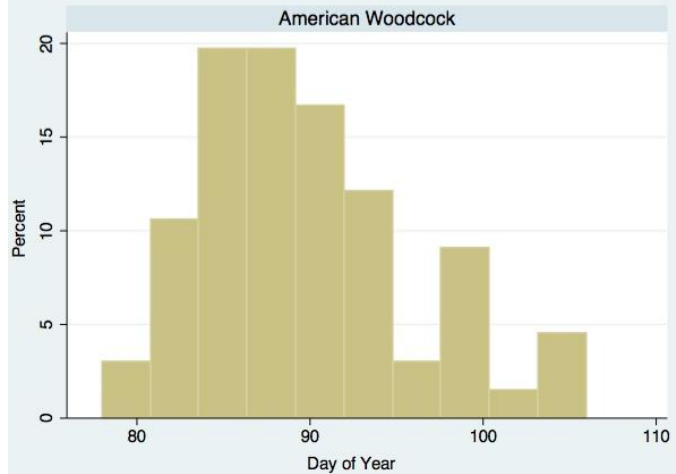
Figure 2. Distribution of first arrival dates for American Woodcock for 1994. The distribution is right-skewed with some leptokurtosis (more pronounced peak and thinner tails than seen in a normal